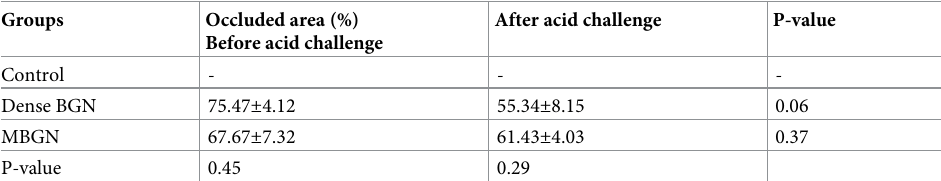
Table 2. Occluded dentinal tubule ratio